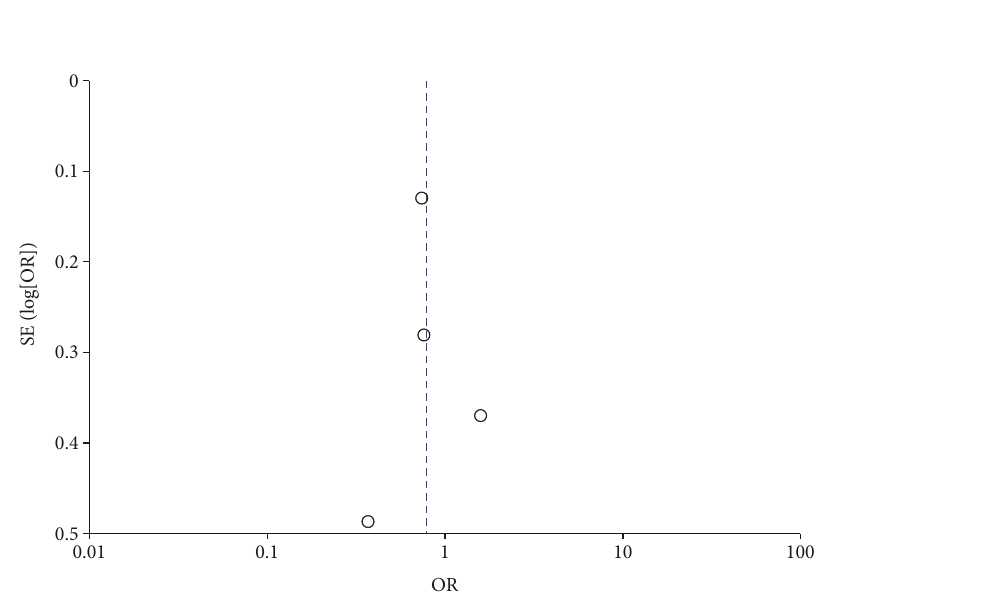
Figure 5: Incidence of severe COVID-19 with and without AR of stay funnel plot.